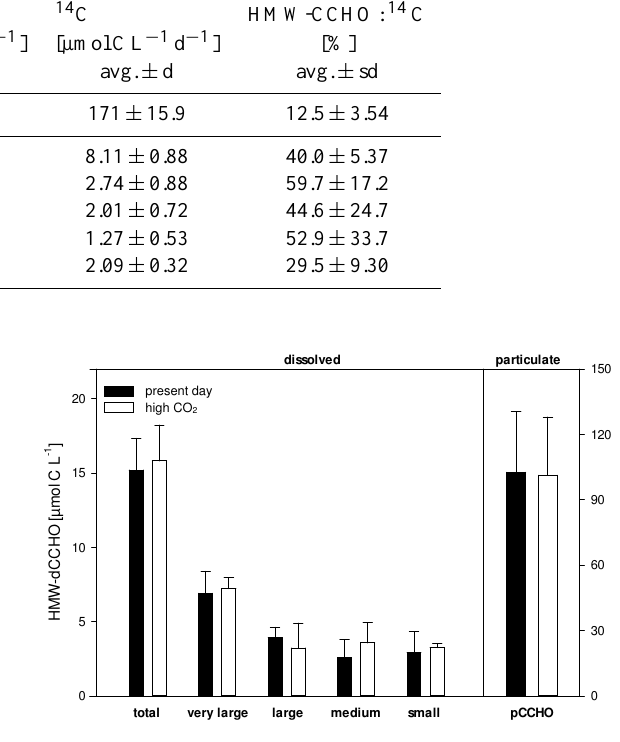
Figure 2. Freshly produced high-molecular-weight (HMW > 1kDa) dissolved combined carbohydrates (HMW- d CCHO, left), and particulate CCHO ( p CCHO, right) [µmol CL − 1 ] derived from E. huxleyi under present-day (filled bars) and high-CO 2 (open bars) conditions. Concentrations are additionally given for each size fraction of HMW- d CCHO. Each bar corresponds to the average ( ± standard deviation) of replicate samplings (samplings 3–5, n = 3) performed during the steady-state period of the